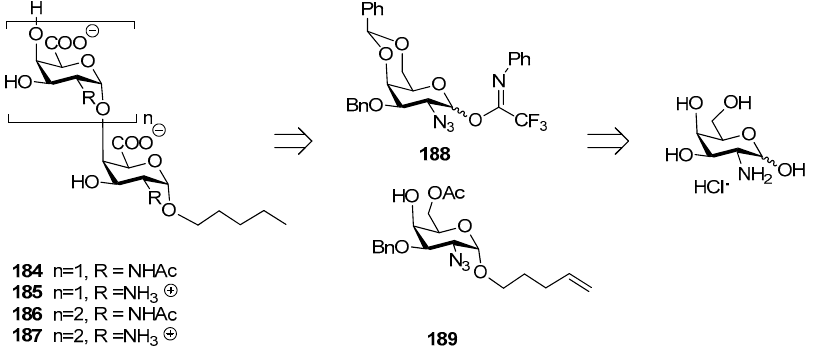
Figure 21. Retrosynthetic analysis of di- and trisaccharide fragments of S. Typhi Vi CPS, reported in Reference [147].